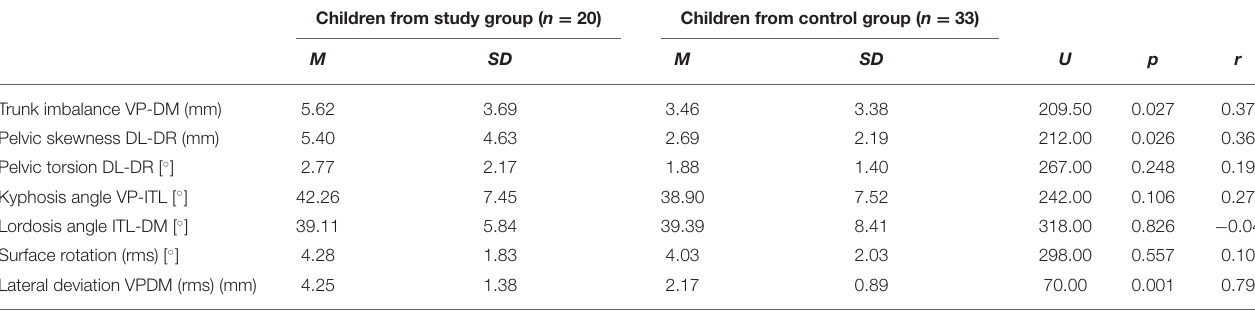
Surface rotation (rms) [ ◦ ]